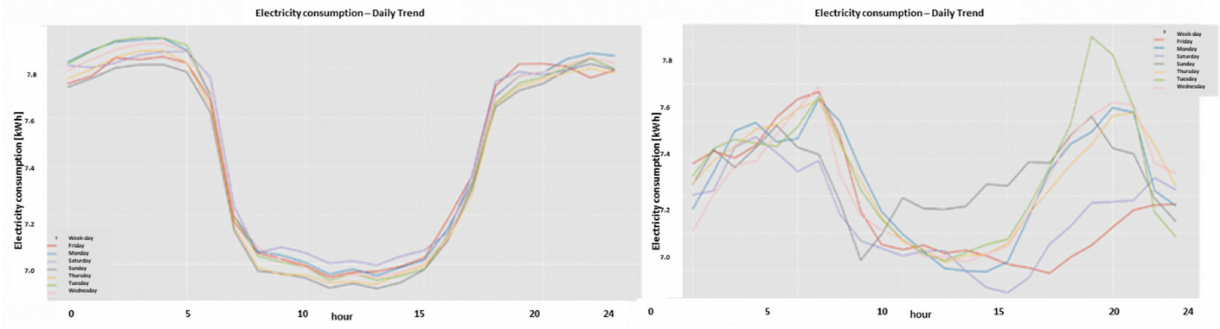
Figure 11. Characteristic daily-hourly trends (0–24) of verified non-fraud ( left ) versus daily-hourly trends of verified fraud ( right ). Here, fraud is actual fraud. Technical loss type differentiation is